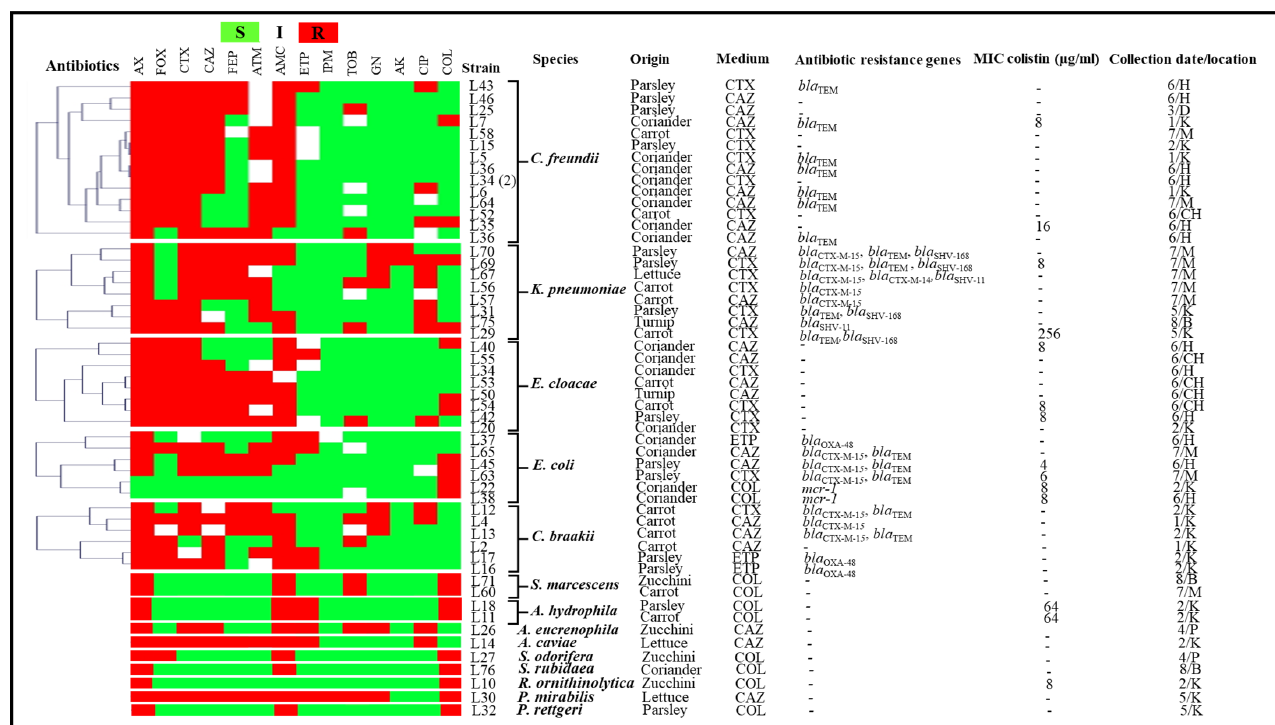
Figure 1. Antibiogram results, β -lactams and colistin resistance mechanisms and origins of our fermenting isolates clustered using the MultiExperimentViewer (MEV) software version 4_6_2. AX, amoxicillin; FOX, cefoxitin; CTX, cefotaxime; CAZ, ceftazidime; FEP, cefepime; ATM, aztreonam; AMC, amoxicillin/clavulanate; ETP, ertapenem; IPM, imipenem; TOB, tobramycin; GN, gentamicin; AK, amikacin; CIP, ciprofloxacin; R, resistant; S, susceptible; I, intermediate; Medium: the selective antibiotic added to the isolation culture medium. K: city of Kechida; P: city of Parc à fourrage; B: city of Bouakal; CH: city of Chouhada; D: downtown; M: 1020 household residence; H: city of